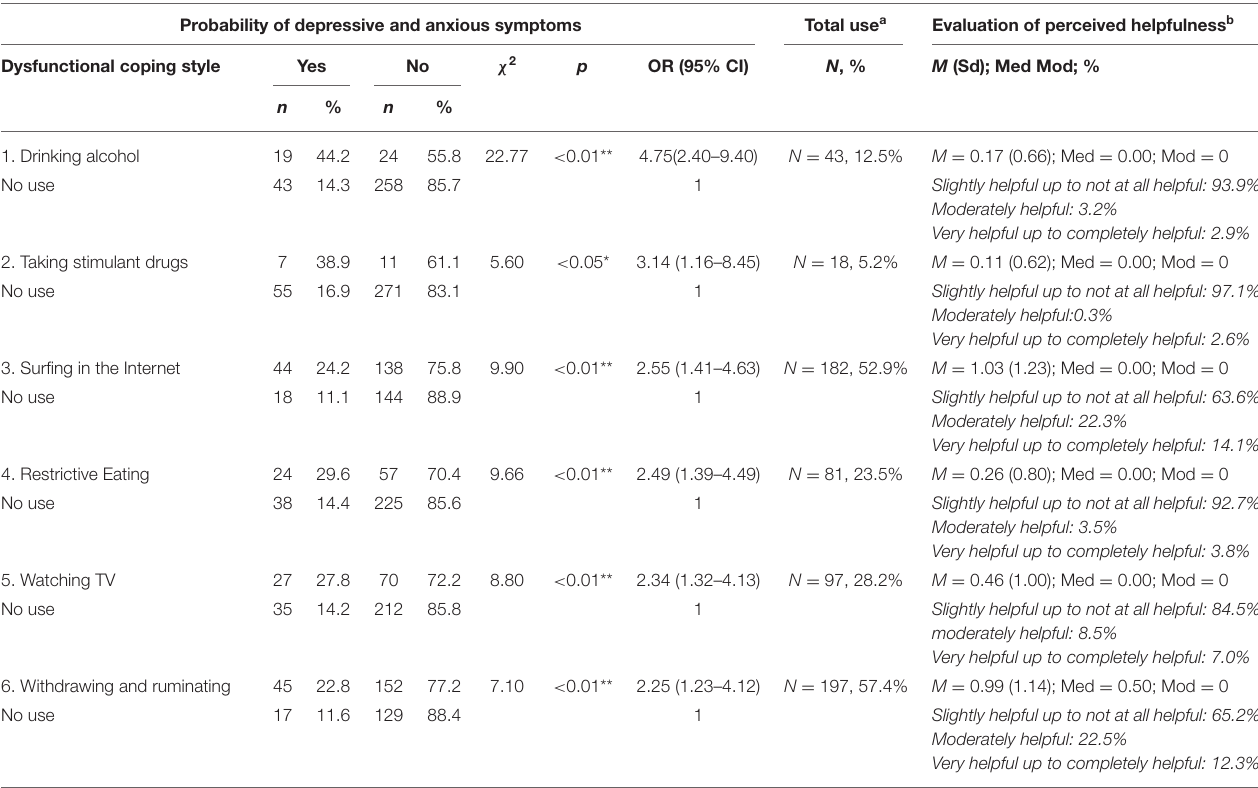
TABLE 6b | Reporting on identified dysfunctional coping strategies with associated OR, frequencies of use, and subjective assessment of the usefulness of the strategy. Probability of depressive and anxious symptoms Total use a Evaluation of perceived helpfulness b Dysfunctional coping